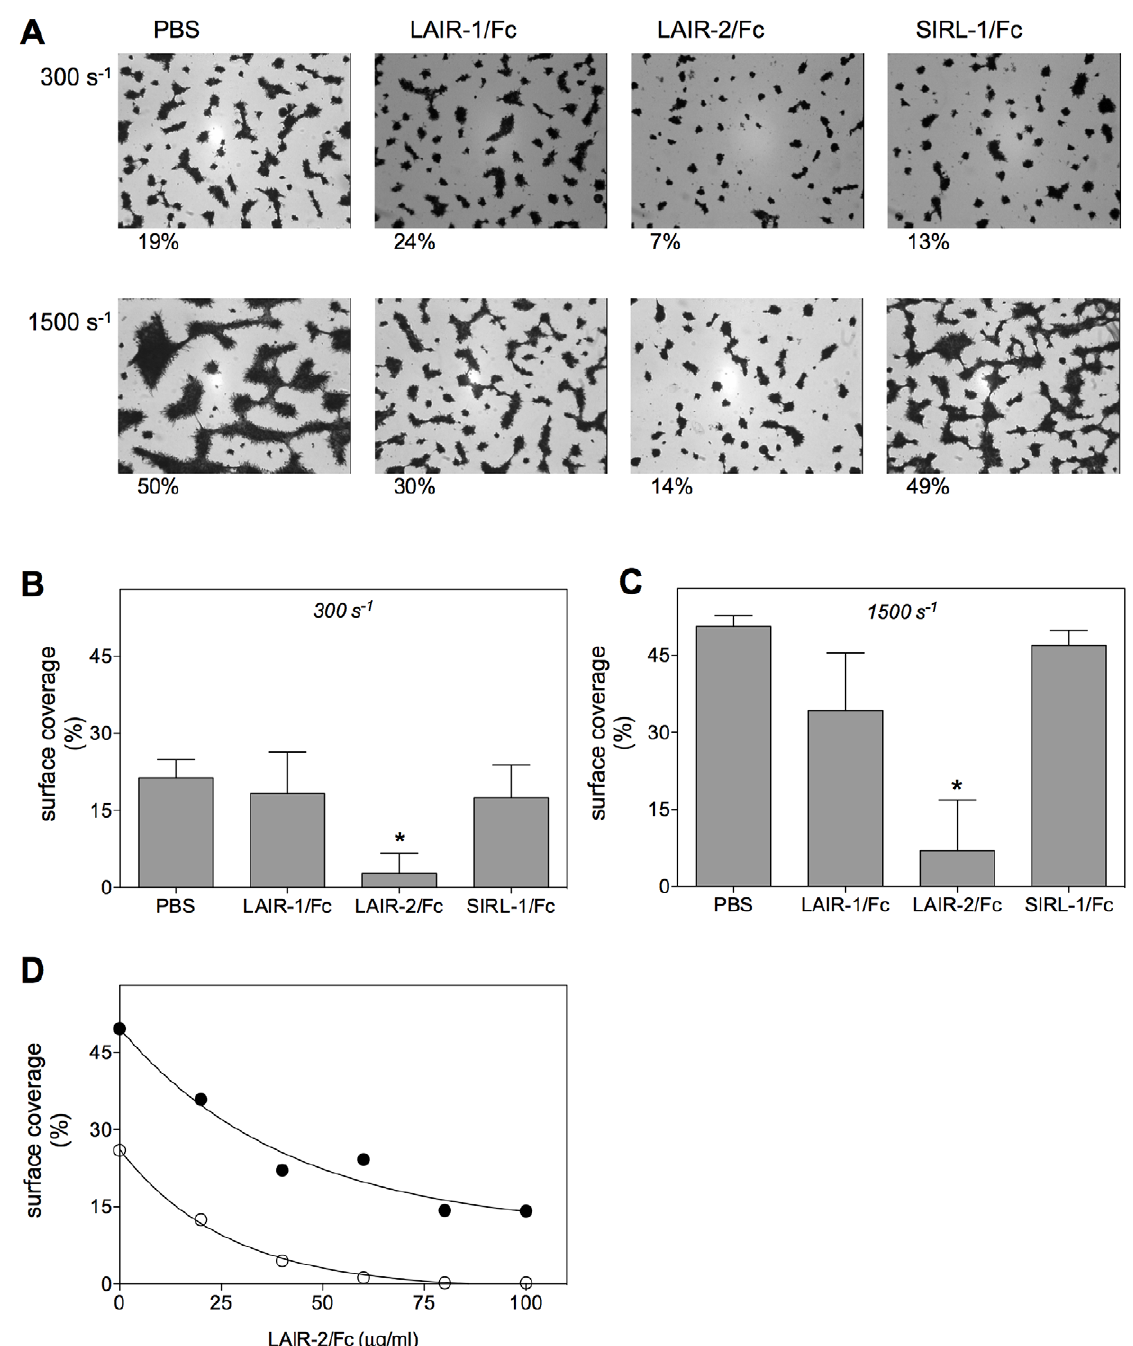
Figure 3. LAIR-2/Fc inhibits adhesion of platelets to collagen under flow conditions. Panel A: Collagen type III-coated coverslips were perfused with whole blood in the absence or presence of 100 m g/ml soluble LAIR-1/Fc, LAIR-2/Fc or SIRL-1/Fc. Representative pictures are shown. Perfusion was performed at a shear rate of 300 s 2 1 (upper panels) or 1500 s 2 1 (lower panels). Percentages below figures indicate percentage surface- coverage for each individual photo. Panels B & C: Quantitative representation of surface coverage of collagen type III-coated coverslips that were perfused in the absence or presence of 100 m g/ml soluble LAIR-1/Fc, LAIR-2/Fc or SIRL-1/Fc at 300 s 2 1 ( panel B) or 1500 s 2 1 ( panel C). Data represent mean 6 SD of three independent perfusions. Panel D: Dose dependent inhibition of surface platelet coverage in the presence of LAIR-2/Fc at shear rates of 300 s 2 1 (open symbols) or 1500 s 2 1 (closed symbols). *: p , 0.005. doi:10.1371/journal.pone.0012174.g003 expressing CHO-cells was unaffected by each of the fusion protein SIRL-1/Fc (0.5 mg/ml). Incubation with FITC-labeled proteins tested, but was markedly reduced in the presence of the collagen in the absence of these proteins resulted in significant a 2 b 1-blocking antibody 15D7 (Fig. 4B). Binding of collagen to binding to GpVI- or a 2 b 1-expressing cells, as analyzed by flow GpVI-expressing cells was also unaffected by the presence of cytometry (Fig. 4A). Binding of collagen to Mn 2 + -stimulated a 2 b 1-